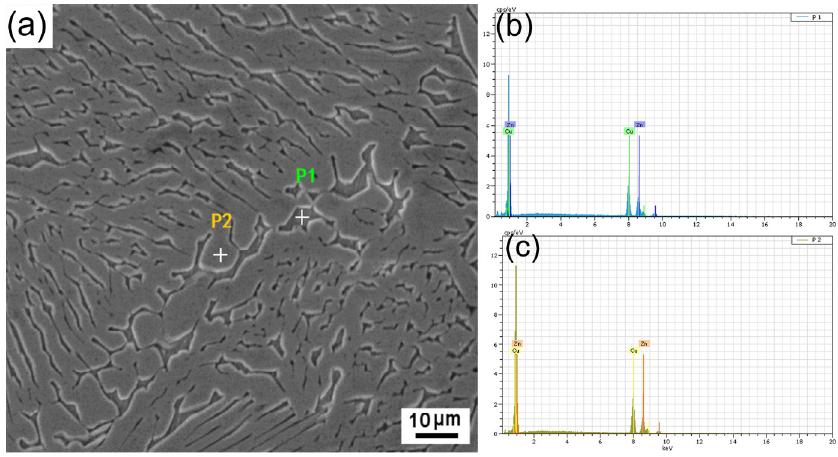
Figure 5. SEM image and EDS pattern of H62 brass. ( a ) SEM image of H62 brass ( b ) EDS pattern at position 2 of the bright area ( c ) EDS pattern at position 1 of the dark area.